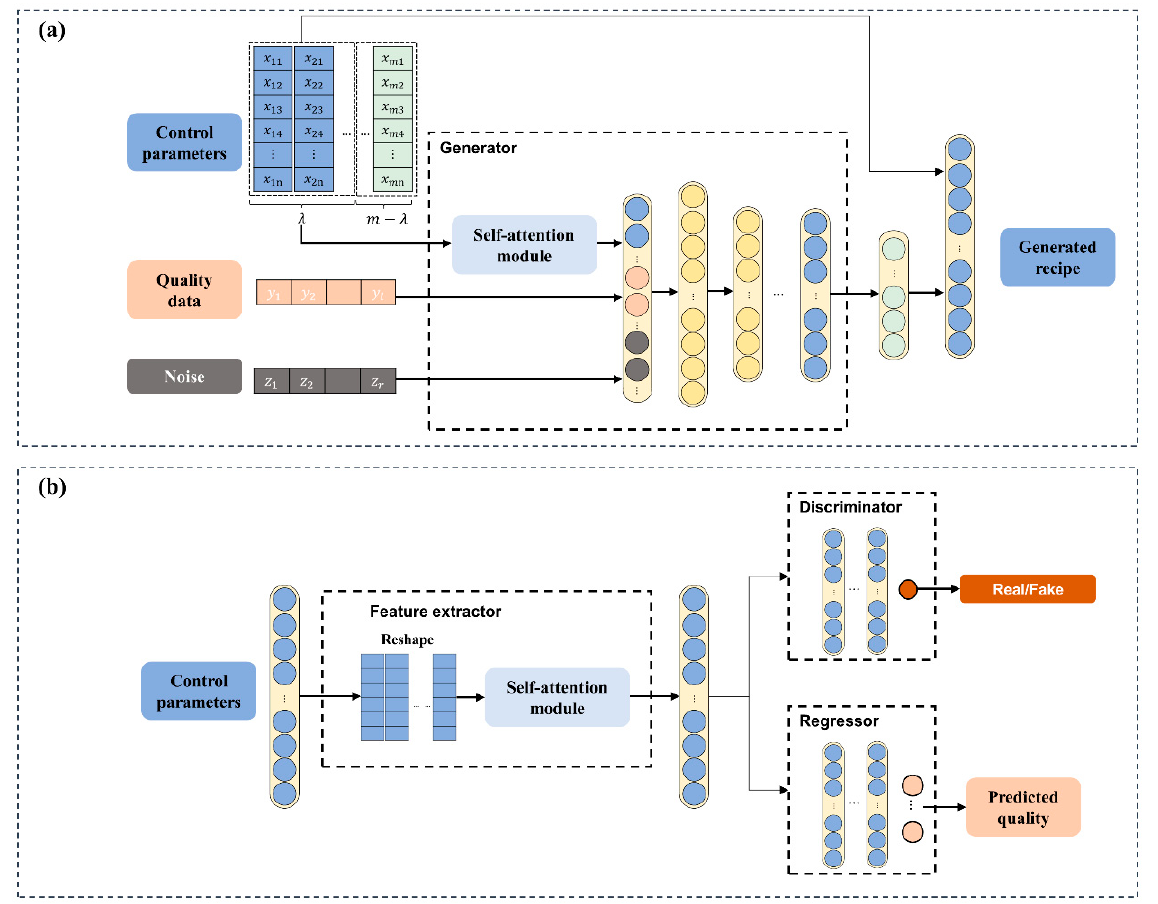
Figure 3. Specific architecture of AR-SAGAN includes ( a ) Generator, ( b ) Feature extractor, Discriminator and regressor.